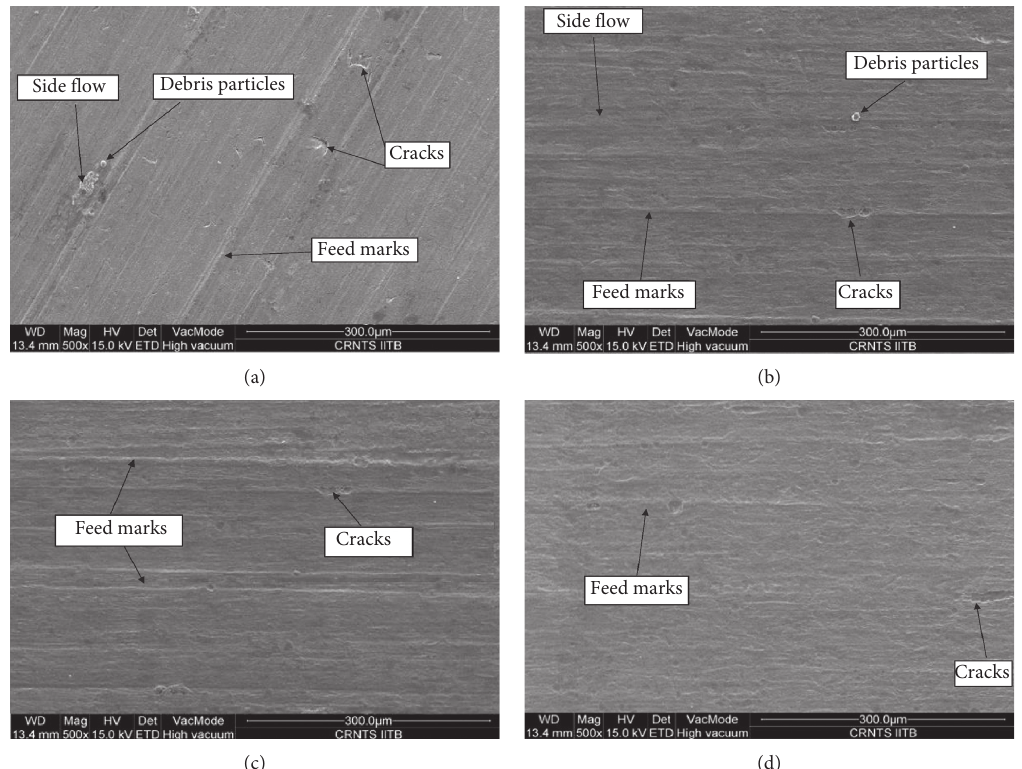
Figure 7: Surface topography of (a) Dry, (b) CCAVT, (c) MQCL, and (d) Hybrid NF-MQCL machining environments at Vc: 200m/min and f: 0.2mm/rev.